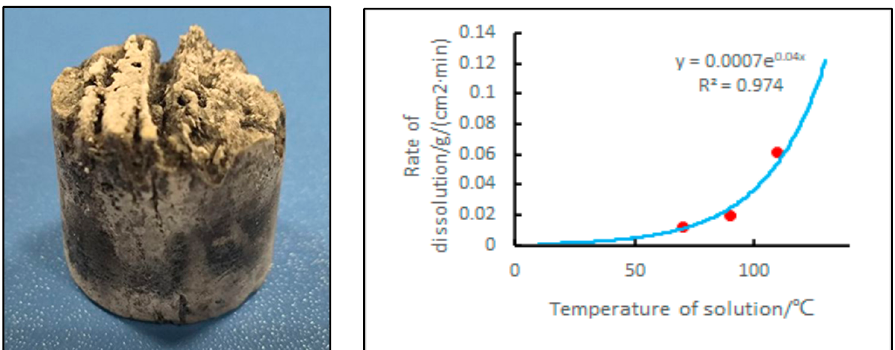
Figure 3. Dissolution of the core at different solution temperatures. ( Left ) salt-dissolved morphology of fracturing fluid after salt dissolution at 90 °C; ( Right ) Influence curve of dissolution rate at different temperatures